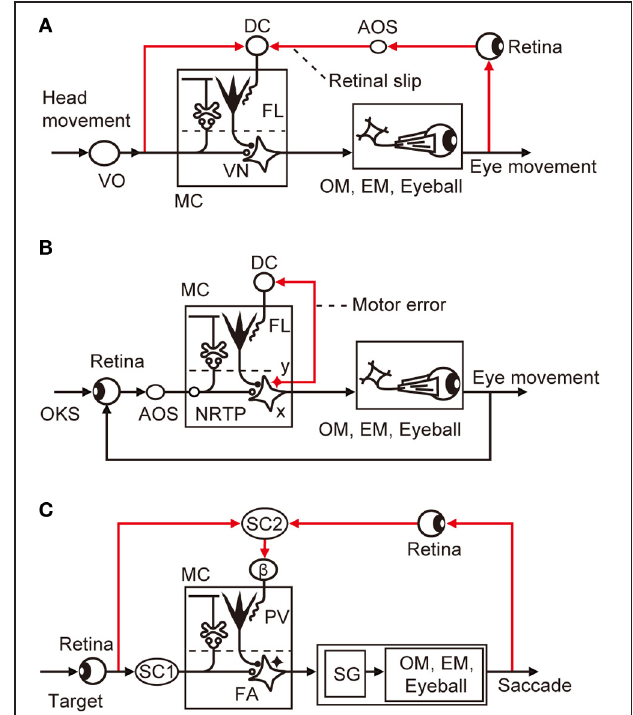
FIGURE 4 | Control system structure for three types of eye movement reflex. (A) VOR. (B) OKR. (C) saccade. Additional abbreviations: β , β subnucleus of inferior olive; DC, dorsal cap; EM, extraocular muscle; FA, fastigial nucleus; NRTP, nucleus reticularis tegmenti pontis; OKS, optokinetic stimulus; OM, oculomotor neurons; SC, superior colliculus; SG, saccade generator; AOS, accessory optic system; FL, flocculus; VN, vestibular nuclear neuron; MC, microcomplex; VO, vestibular organ; PV, posterior vermis; x, vestbuloocular relay neuron; y, vestibular nuclear neuron working in parallel with